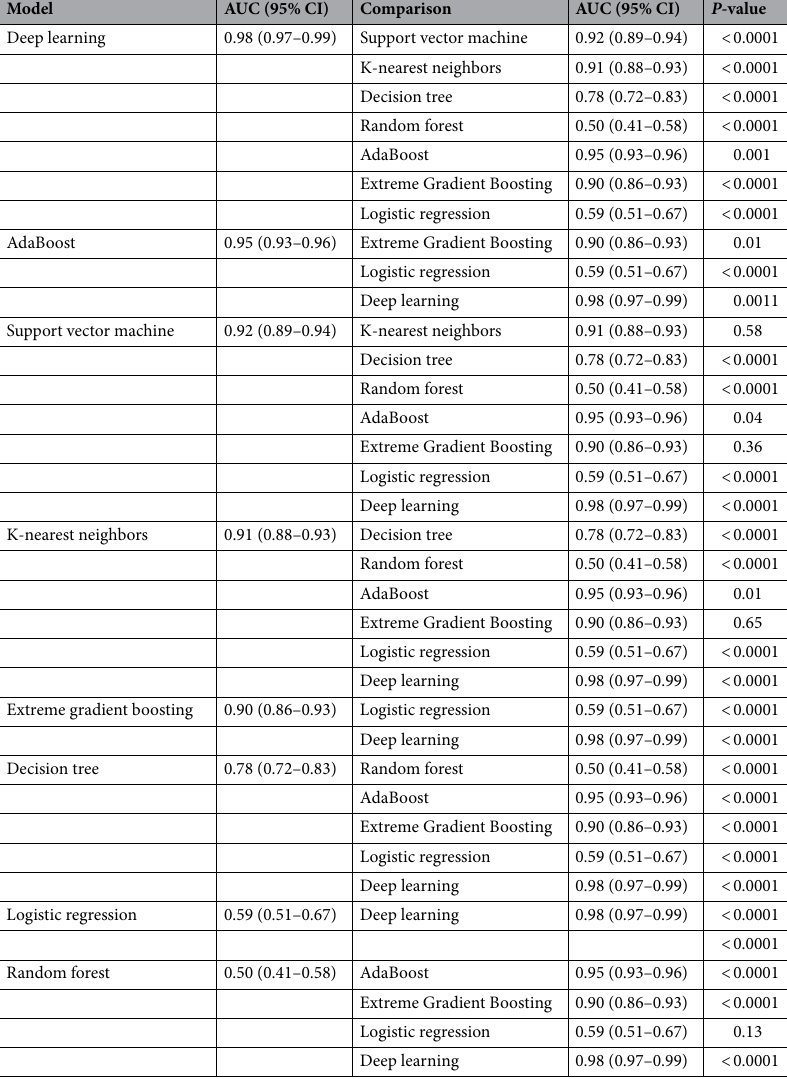
Table 3. Comparison among machine learning and deep learning